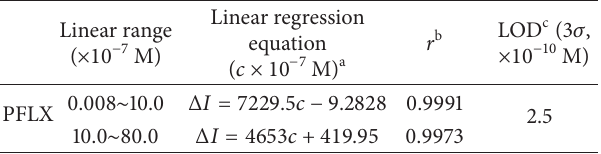
Table 2: Analytical parameters for the determination of PFLX. Linear